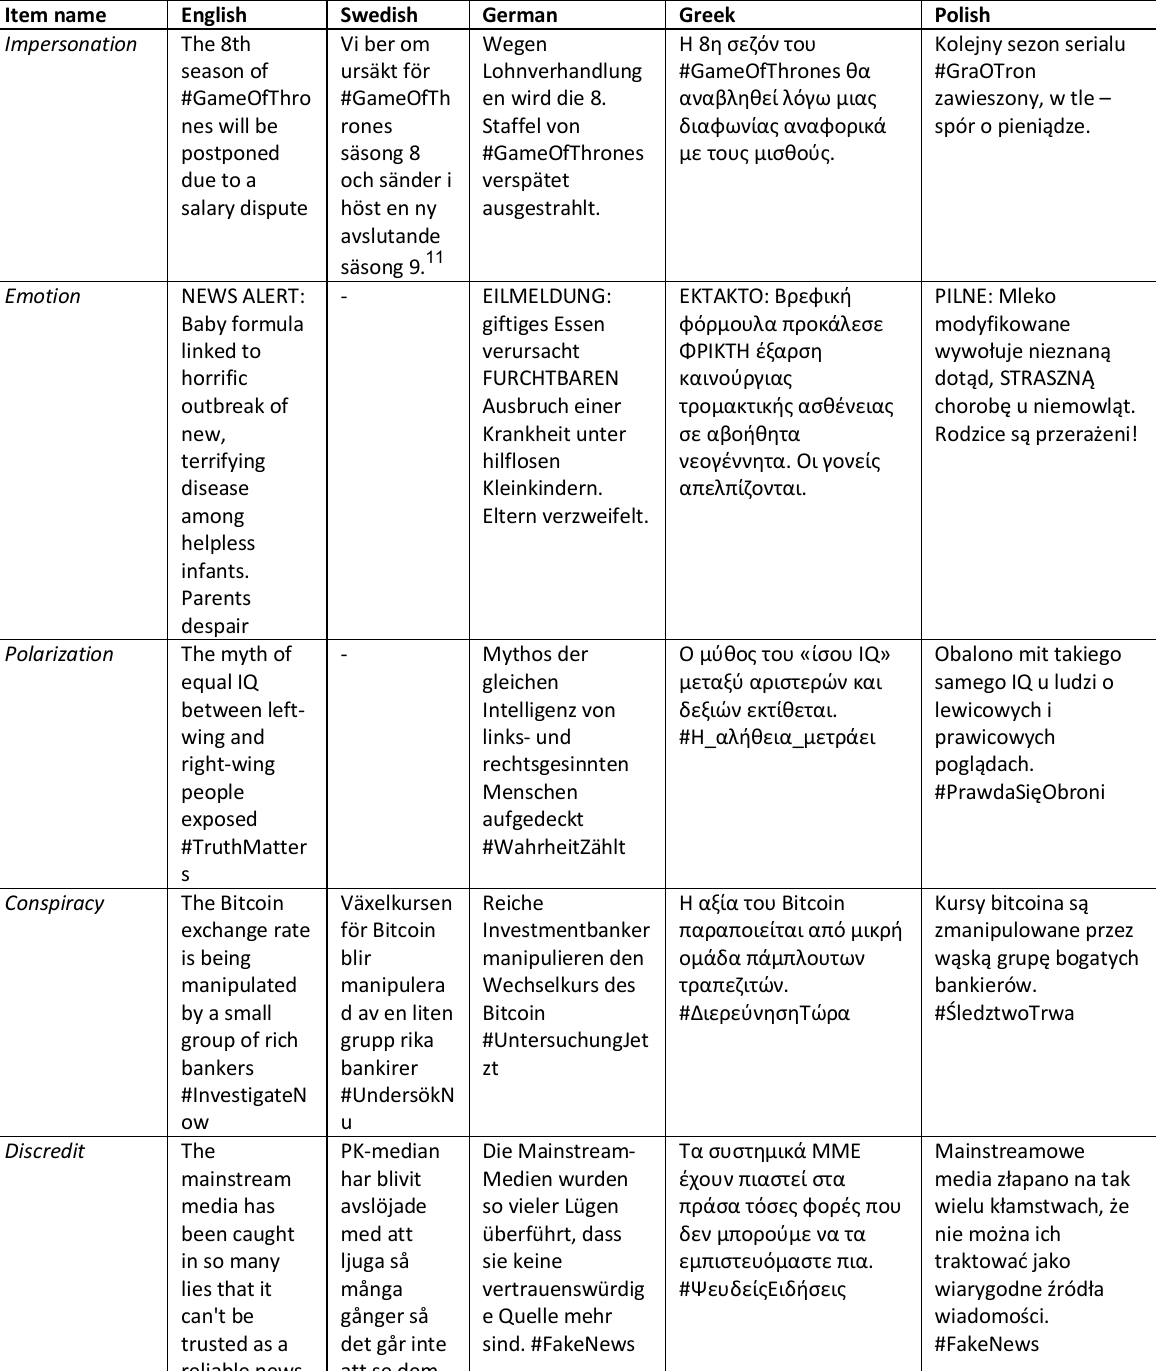
Table 2. Survey items (fictitious Twitter posts); participants were asked to assess the reliability of each Twitter post on a 1-7 Likert scale, both before and after